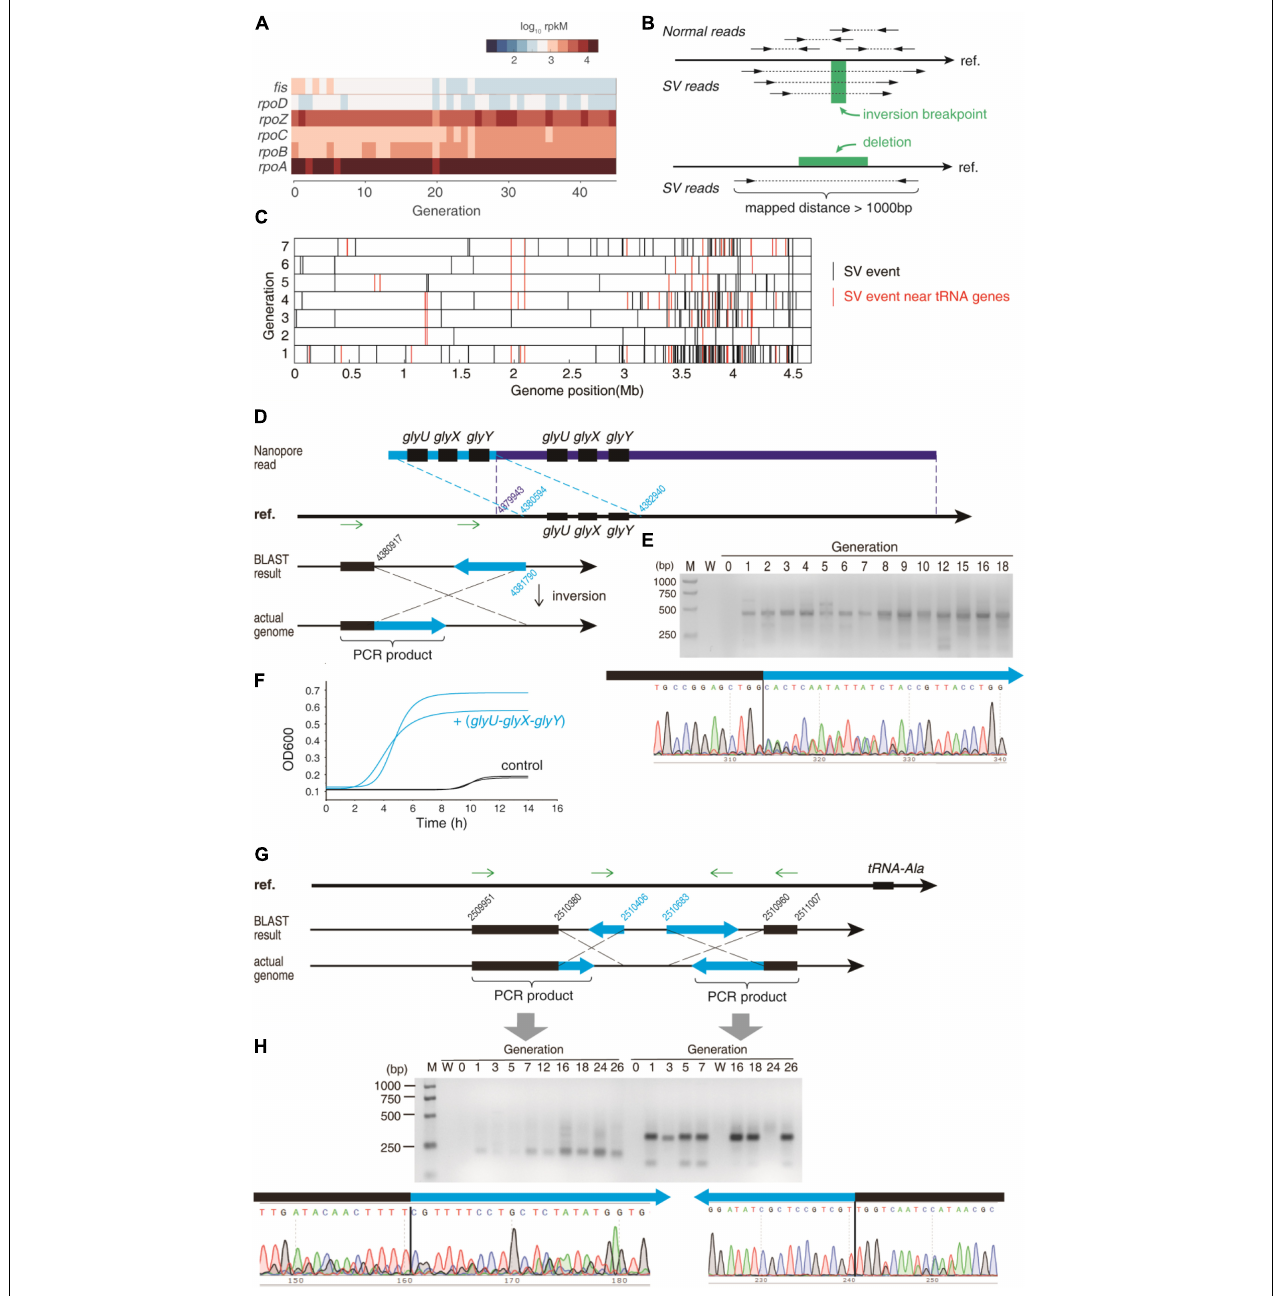
FIGURE 4 | The SV that affects the tRNAs. (A) The expression levels of the major transcription factors that are involved in tRNA expression. (B) Detecting SV events using paired-end reads. The WGS library was constructed as ∼ 300 bp insert. After mapped to the reference genome sequence (“ref.”), the two ends of the same read should be mapped in the opposite direction. An inversion breakpoint candidate is identified if the two ends of the same read are mapped in the same direction. Deletion of a fragment is detected if the two ends of the same read are mapped in the opposite direction but far apart. Only the uniquely mapped reads were taken into consideration. (C) The SV events were detected using WGS data during the early stage. Red bars represent the SV events near the tRNA genes, and the black bars represent the other events. (D) An example of a duplication event and an inversion event near glyU-glyX-glyY operon. (E) The gel electrophoresis of the PCR product validating the inversion event in (D) . The PCR was performed using the two primers that are indicated as green arrows in (D) . Lane M = marker; lane W = water control (negative control using water as template). The Sanger sequencing of the PCR product is exhibited for the junction of the inversion. (F) Growth curve of the BW25113 expressing the glyU-glyX-glyY tandem repeat and the control strain under the CIP stress at 1/2 MIC of the sensitive strain. Growth curves were measured as two independent biological replications. (G) Two inversion events near the tRNA-Ala gene. (H) The gel electrophoresis of the PCR product validating the inversion events in (G) . The PCR was performed using the primers that are indicated as green arrows in (G) . Lane M = marker; lane W = water control (negative control using water as template). The Sanger sequencing of the PCR products are exhibited for the junctions of the inversion.